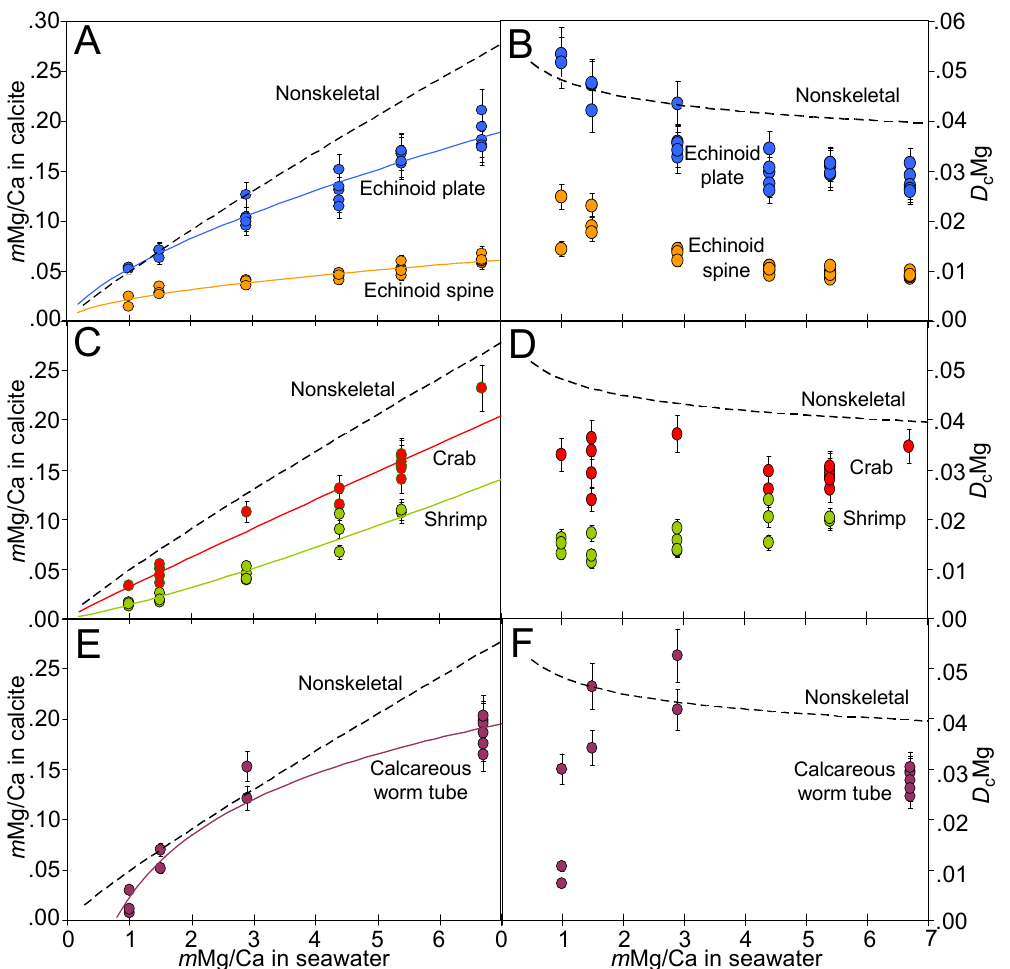
Fig. 25. Mg fractionation data for four calcite-secreting marine animals. (A) Mg fractionation curves for echinoid spines ( Eucidaris tribu- loides , closed orange circles, Mg/Ca C =0.0213Mg/Ca sw0 . 538 ; R 2 =0.873, n =23) and coronal plates ( Eucidaris tribuloides , closed blue circles, Mg/Ca C =0.0516Mg/Ca sw0 . 668 ; R 2 =0.959, n =23). (B) Mg fractionation coefficients for echinoid spines (closed orange circles) and coro- nal plates (closed blue circles). (C) Mg fractionation curves for crabs ( Perchon gibbesi , closed red circles, Mg/Ca C =0.0317Mg/Ca sw0 . 956 , R 2 =0.964, n =16) and shrimp ( Palaemonetes pugio , closed green circles, Mg/Ca C =0.0134Mg/Ca sw1 . 21 , R 2 =0.955, n =15). (D) Mg frac- tionation coefficients for crabs (closed red circles) and shrimps (closed green circles). (E) Mg fractionation curve for calcareous serpulid worm tubes ( Hydroides crucigera , closed purple circles, Mg/Ca C =0.0883 ln(Mg/Ca sw ) +0.0227, R 2 =0.956, n =13). (F) Mg fractionation coefficients for calcareous serpulid worm tubes (closed purple circles). For each of the animals investigated, skeletal Mg/Ca C increased with Mg/Ca sw . However, D c Mg was not fixed, as it also varied (non-linearly) with Mg/Ca sw . Dashed black lines are Mg fractionation curves and coefficients for nonskeletal calcite (F¨uchtbauer and Hardie 1976). D c Mg is Mg fractionation coefficient equal to Mg/Ca C divided by its corresponding Mg/Ca sw . Mg fractionation curves are fit to data using least squares regression. Vertical bars represent uncertainty due to analytical error and specimen